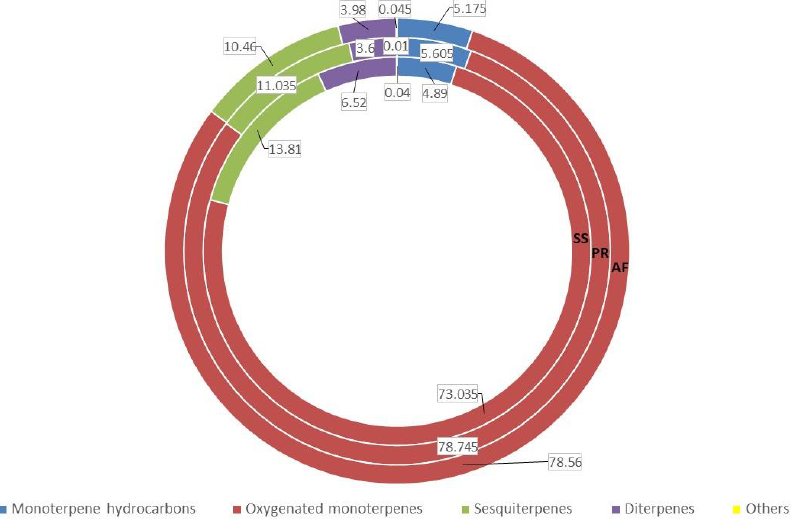
Figure 2. Class of compounds of the essential oils of the local populations in the study. Local population code: PR = Prizzi; AF = Alcara Li Fusi; SS = S. Stefano Quisquina.